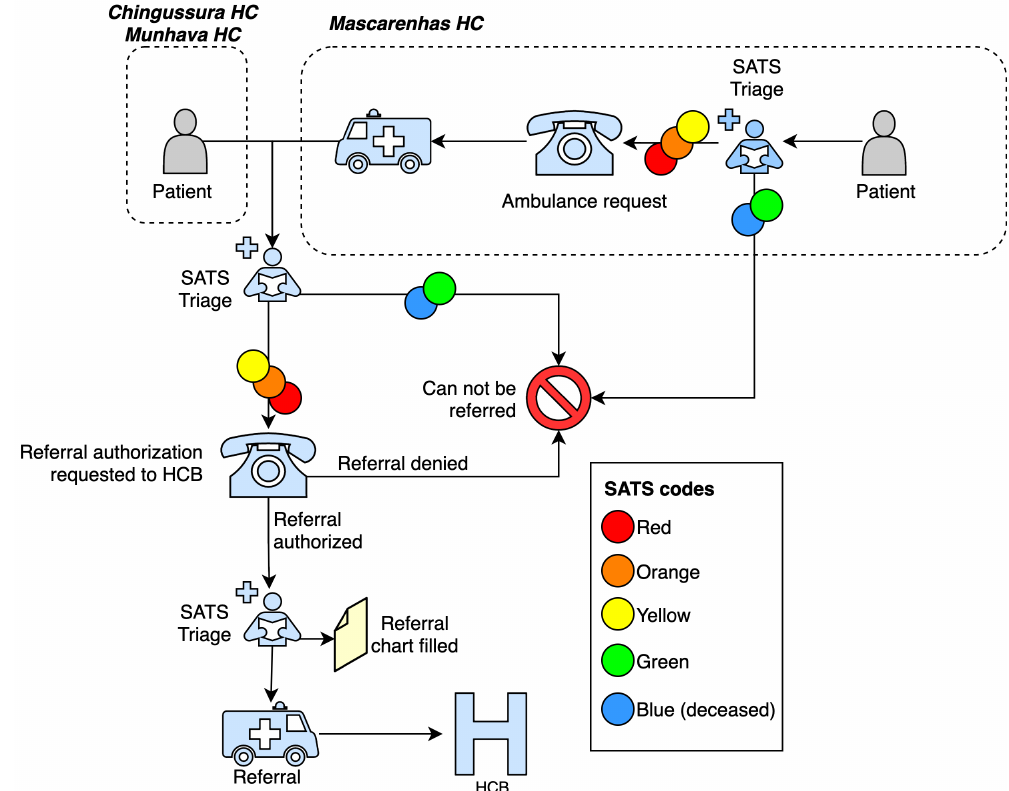
Figure A1. Dispatch